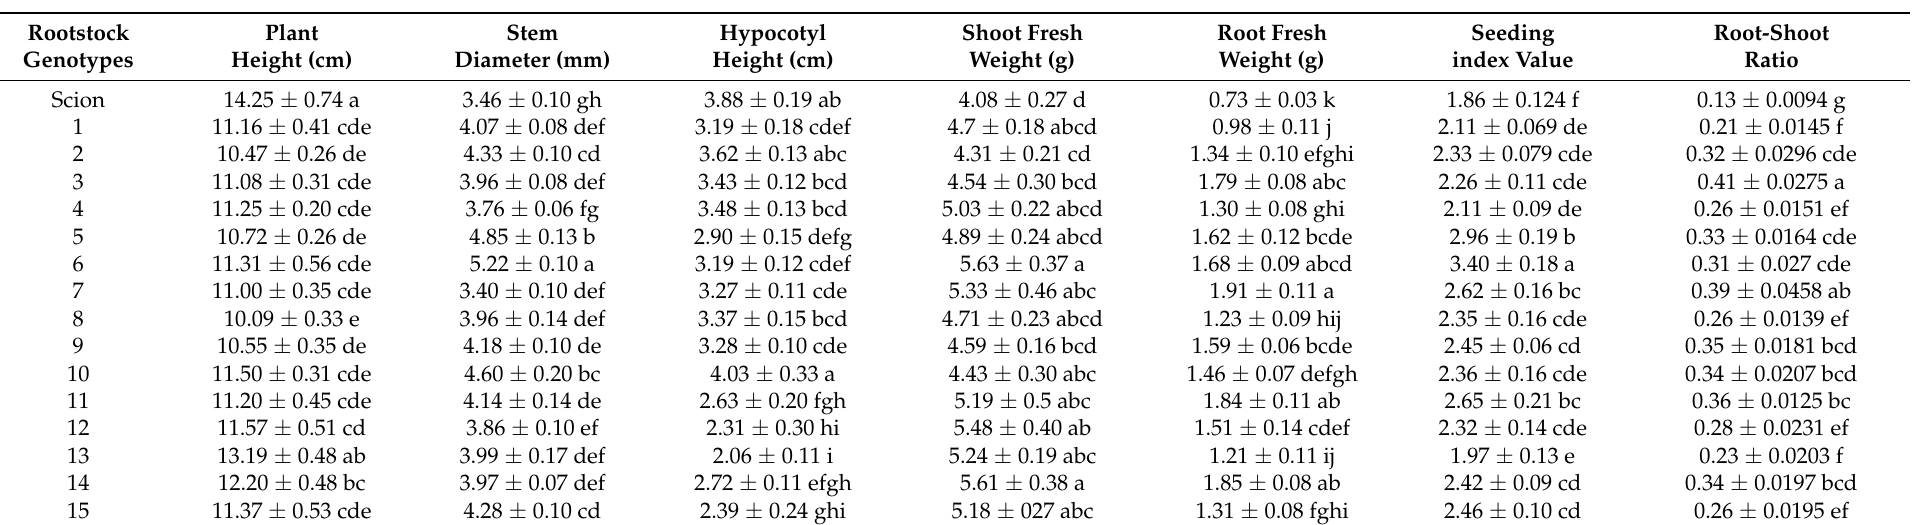
Table 2. Morphological and growth parameters of grafted tomatoes with the 15 rootstock